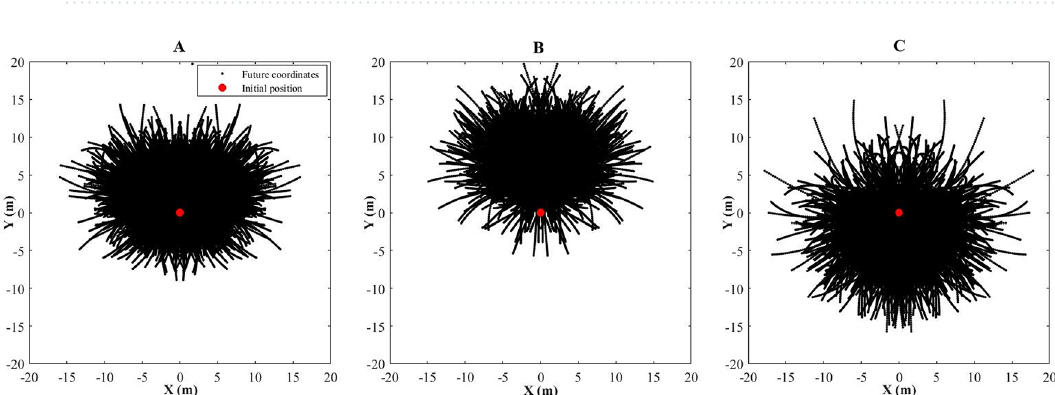
Figure 2. Example of displacements with velocities from 5 to 6 m/s, acceleration from 2 to 3 m/s 2 , and angles rotated 90 degrees and translated to origin in 0 at x and y axis future positions at one-second time window generating a movement model (A) and the same movement model after mirroring process (B) .